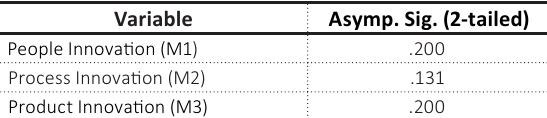
Table 3. Normality test for the 1 st regression